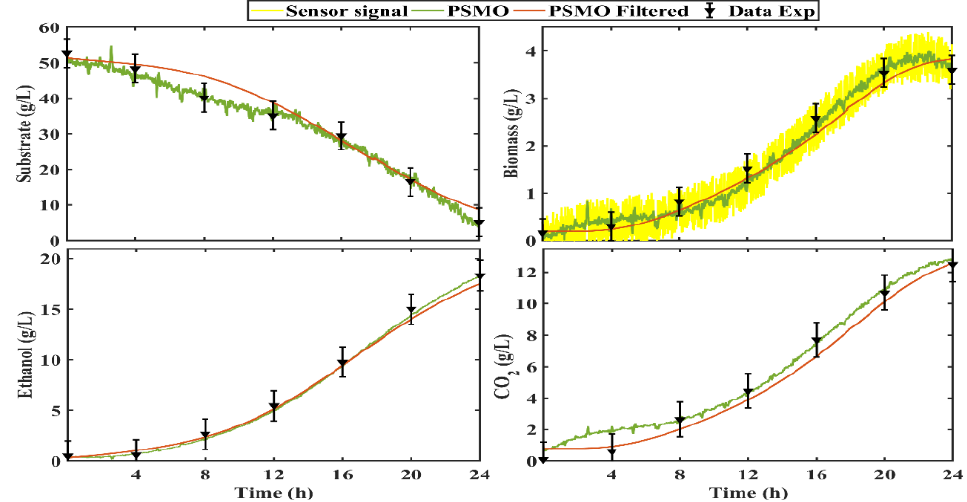
Figure 11. PSMO implementation using a filtered sensor signal.